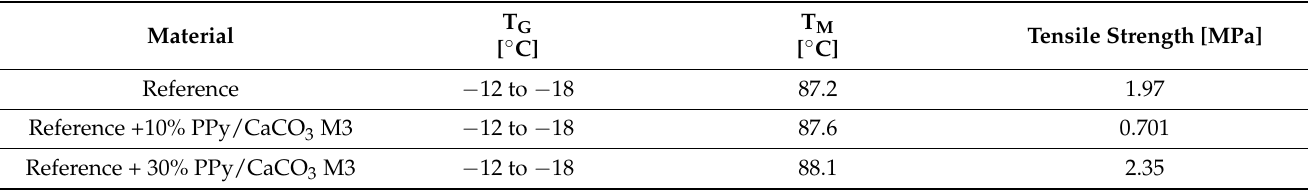
Table 2. Overview of reference sample Levirex ® LX B/518, PPy/CaCO 3 particles (30 wt% and 10 wt%) added to Levirex ® LX B/518 regarding their glass transition temperatures (T G ), melting temperatures (T M ) and tensile